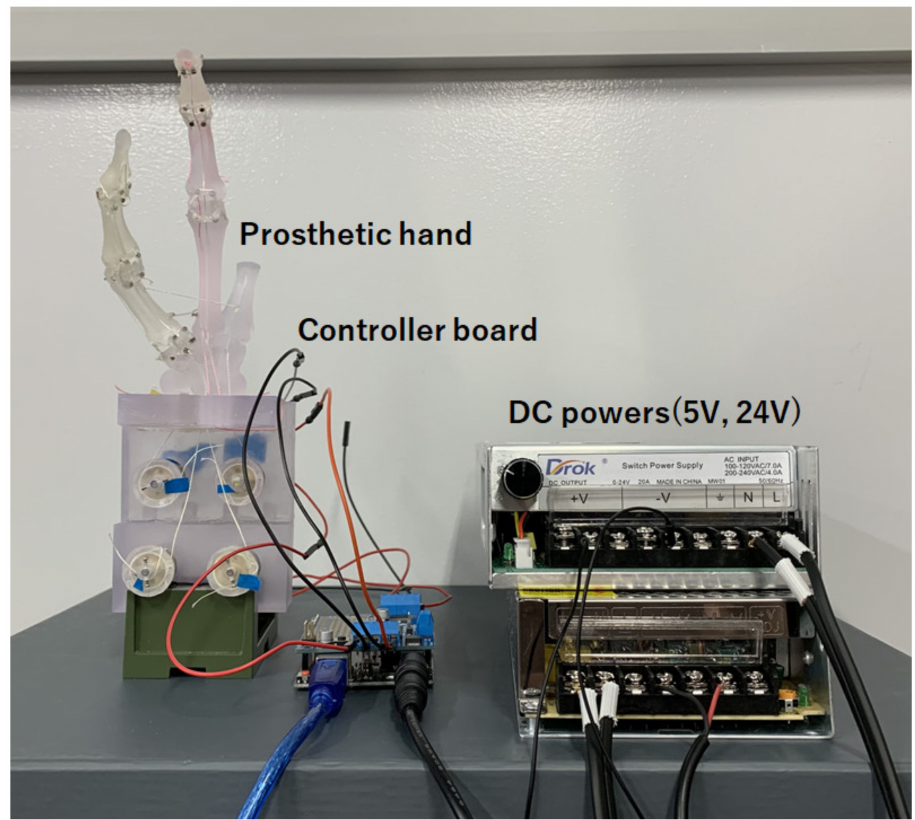
Figure 6. The proposed system for prosthetic